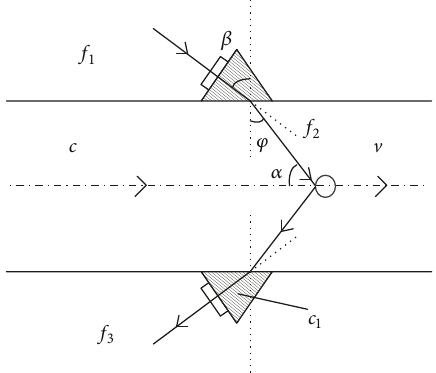
Figure 1: Basic principle of Doppler speed